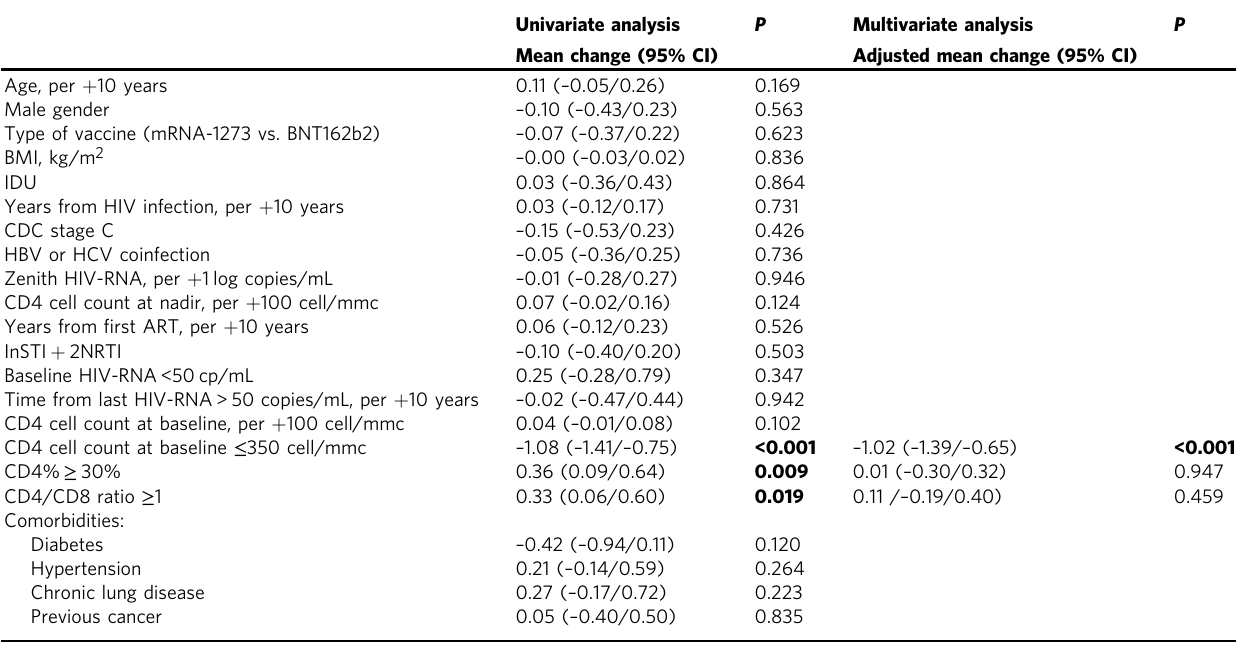
Bold values indicate statistical signi fi cance p ≤ 0.05. ART antiretroviral therapy, BMI body mass index, CI con fi dence intervals, HBV hepatitis B virus, HCV hepatitis C virus, IDU injecting drug users, InSTI integrase strand transfer inhibitors, MSM men who have sex with men, NRTI nucleoside reverse transcriptase inhibitors, NNRTI non-nucleoside reverse transcriptase inhibitors, OIR optimal immunological recovery, PI protease